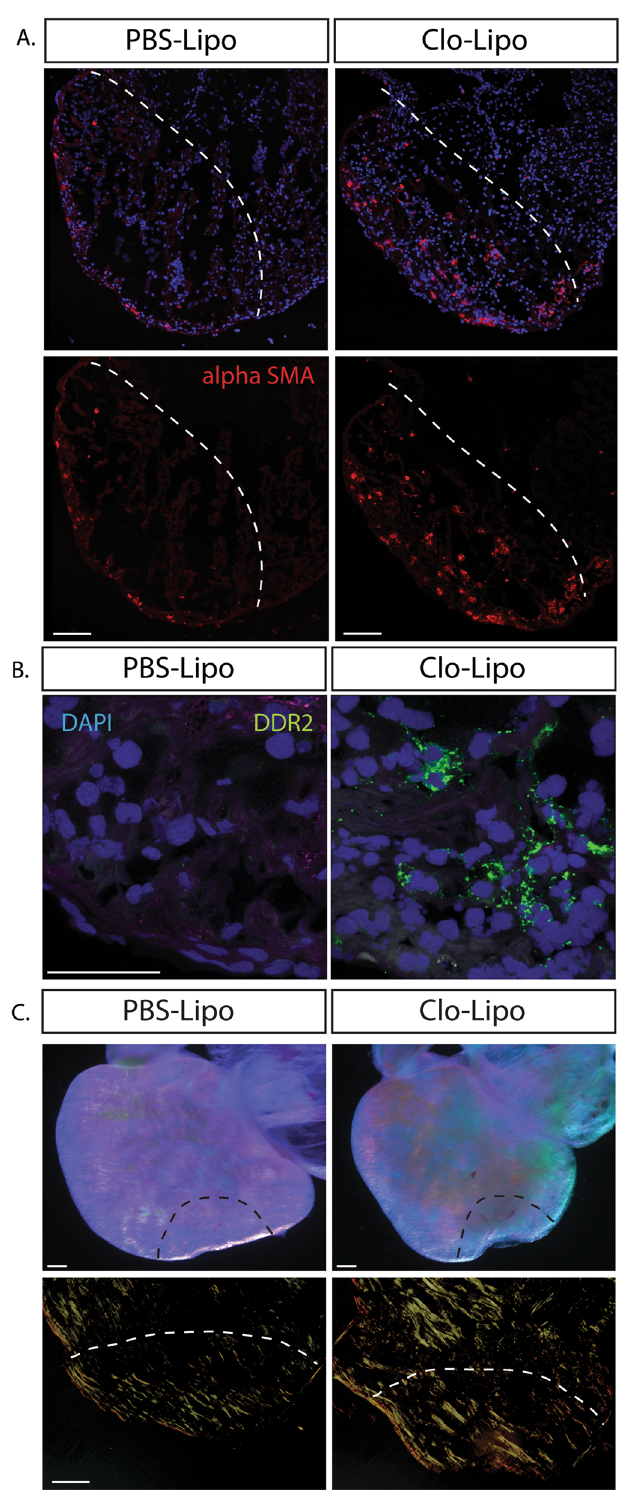
indicates that macrophages are immediately required to control fi broblast differentiation. Whereas early macrophage depletion could be expected to affect viability and recovery from surgery due to associated risk of infection, animals surviving this initial period are at increased risk at much later time points, coinciding with progressive fi brosis leading to terminal heart failure. These